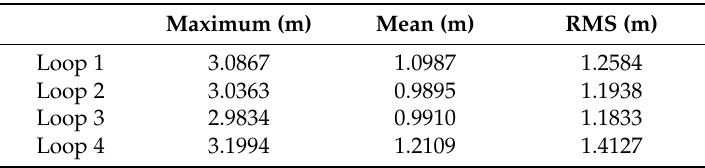
Table 6. Positioning errors in different